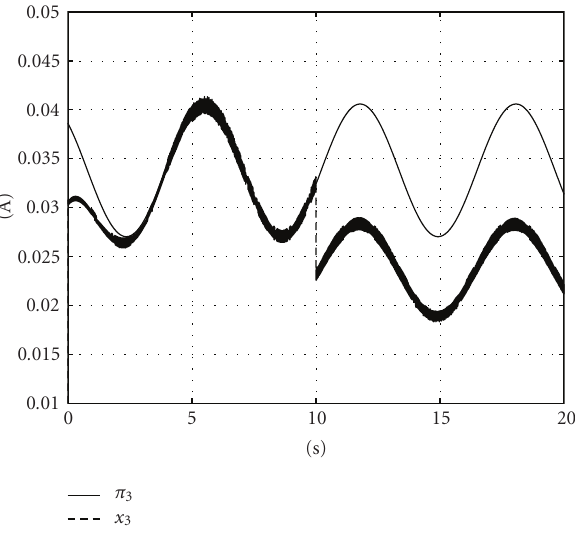
Figure 9: Current signals.